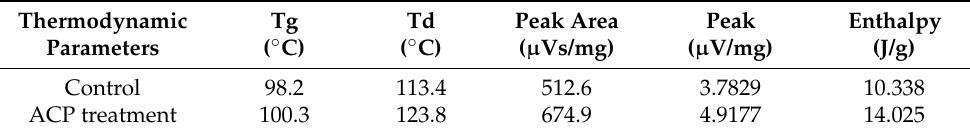
Table 2. Thermodynamic parameters of control and ACP–treated film, with the amount of soy protein being 10% and glycerol being 2.8%.